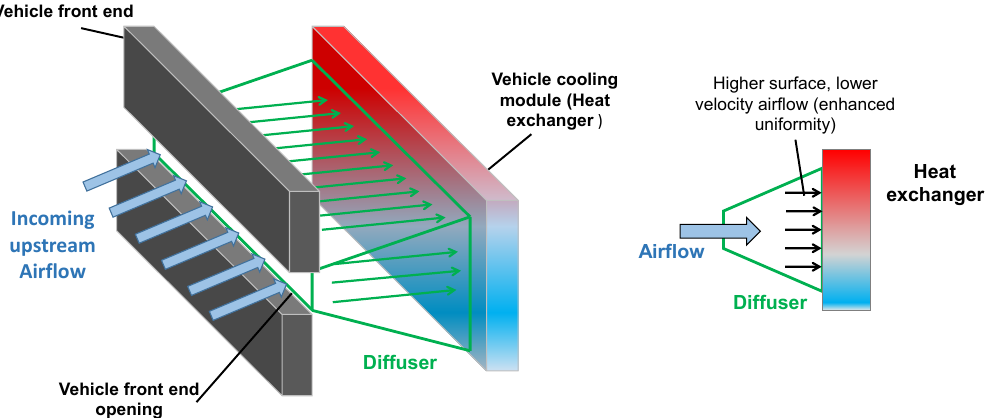
Figure 2. New suggested design: use of a diffuser in the cooling module.